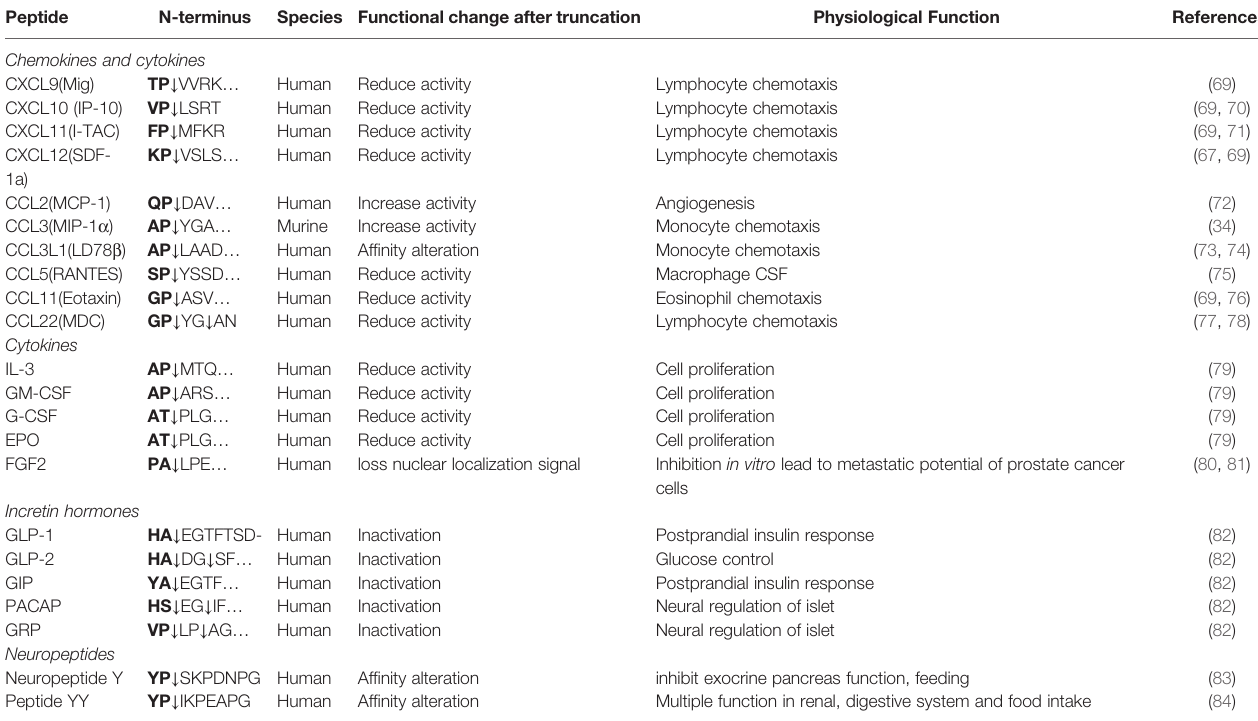
TABLE 2 | Summary of DPP4